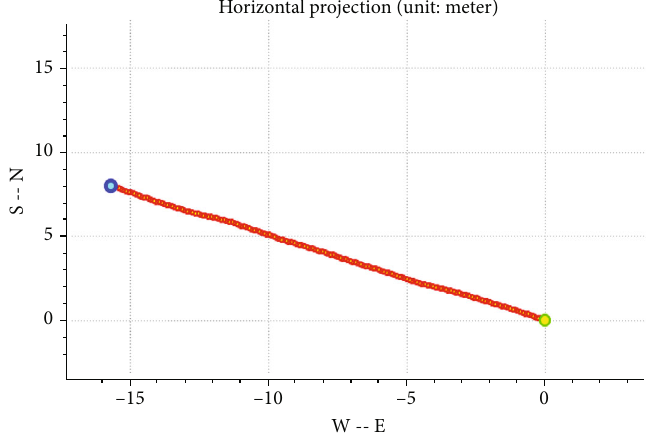
Figure 12: Horizontal projection of gas drainage borehole.